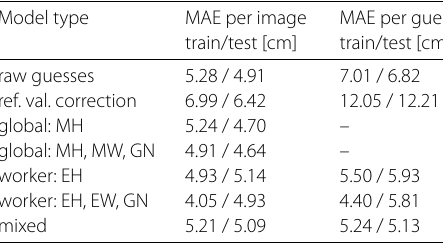
Table 3 Correction models for height